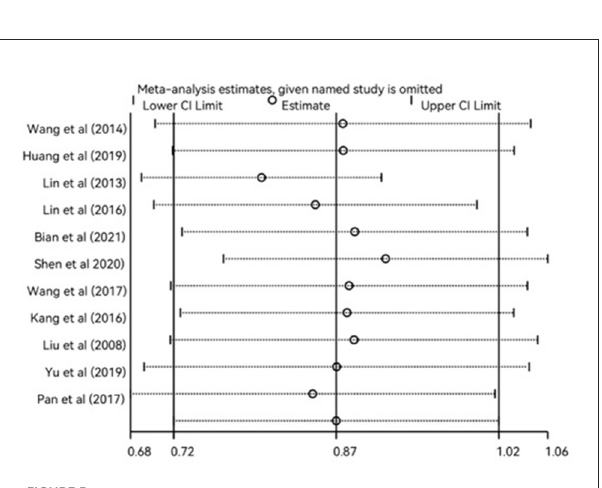
FIGURE5 Sensitivity analysis of the relationship between eye exercises and myopia in children and adolescents in multivariate analysis.